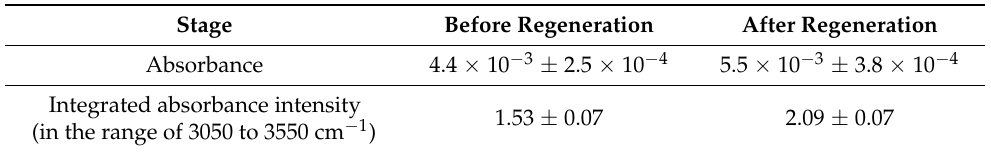
Table 1. Amide A peak values of E. coli antibodies measured by FTIR before and after exposure to the regeneration kit ( n = 3 samples).